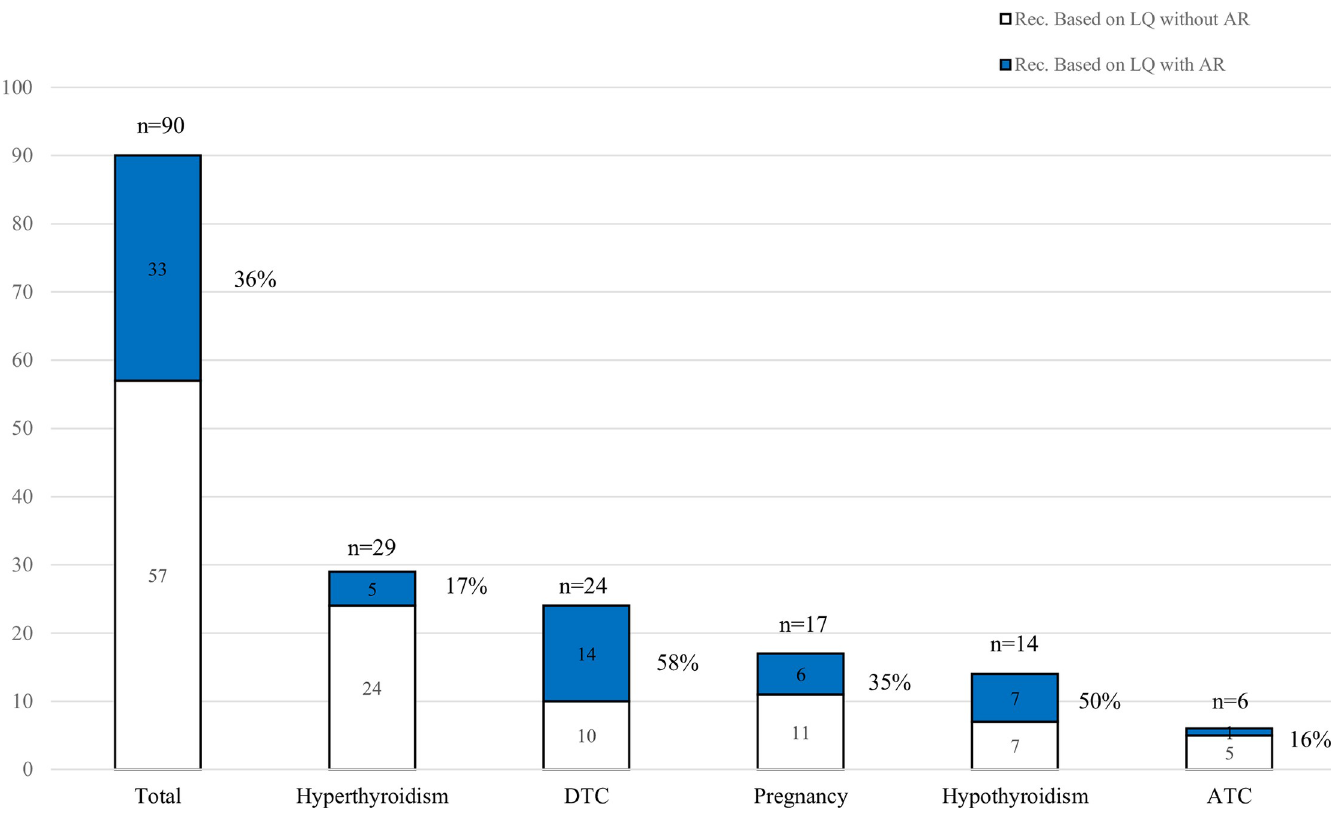
Fig 3. Proportion of recommendations based on low-quality evidence with and without active research. Percentages represents recommendations with low-quality of evidence with active research. LQ: Low-quality; Rec: Recommendation; AR: Active Research; DTC: Differentiates Thyroid Cancer; ATC: Anaplastic Thyroid Cancer.